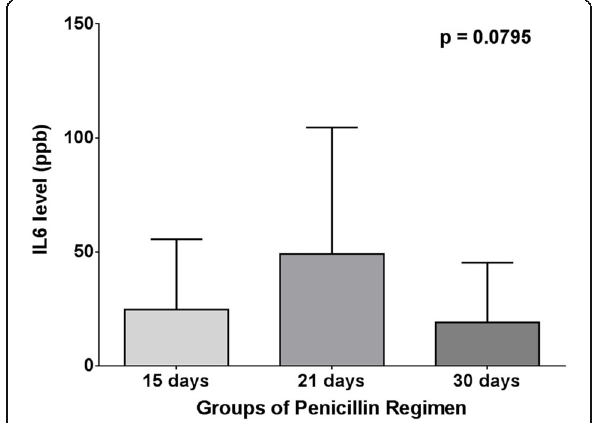
Fig. 11 One-way ANOVA test for IL-6 between penicillin and regimen groups